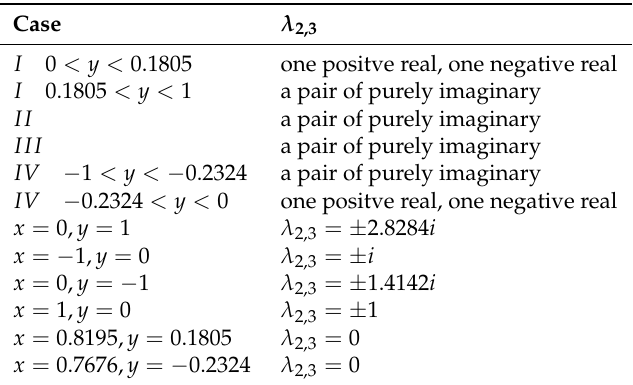
Table 2. Eigenvalues of the system (3) for k = 1.